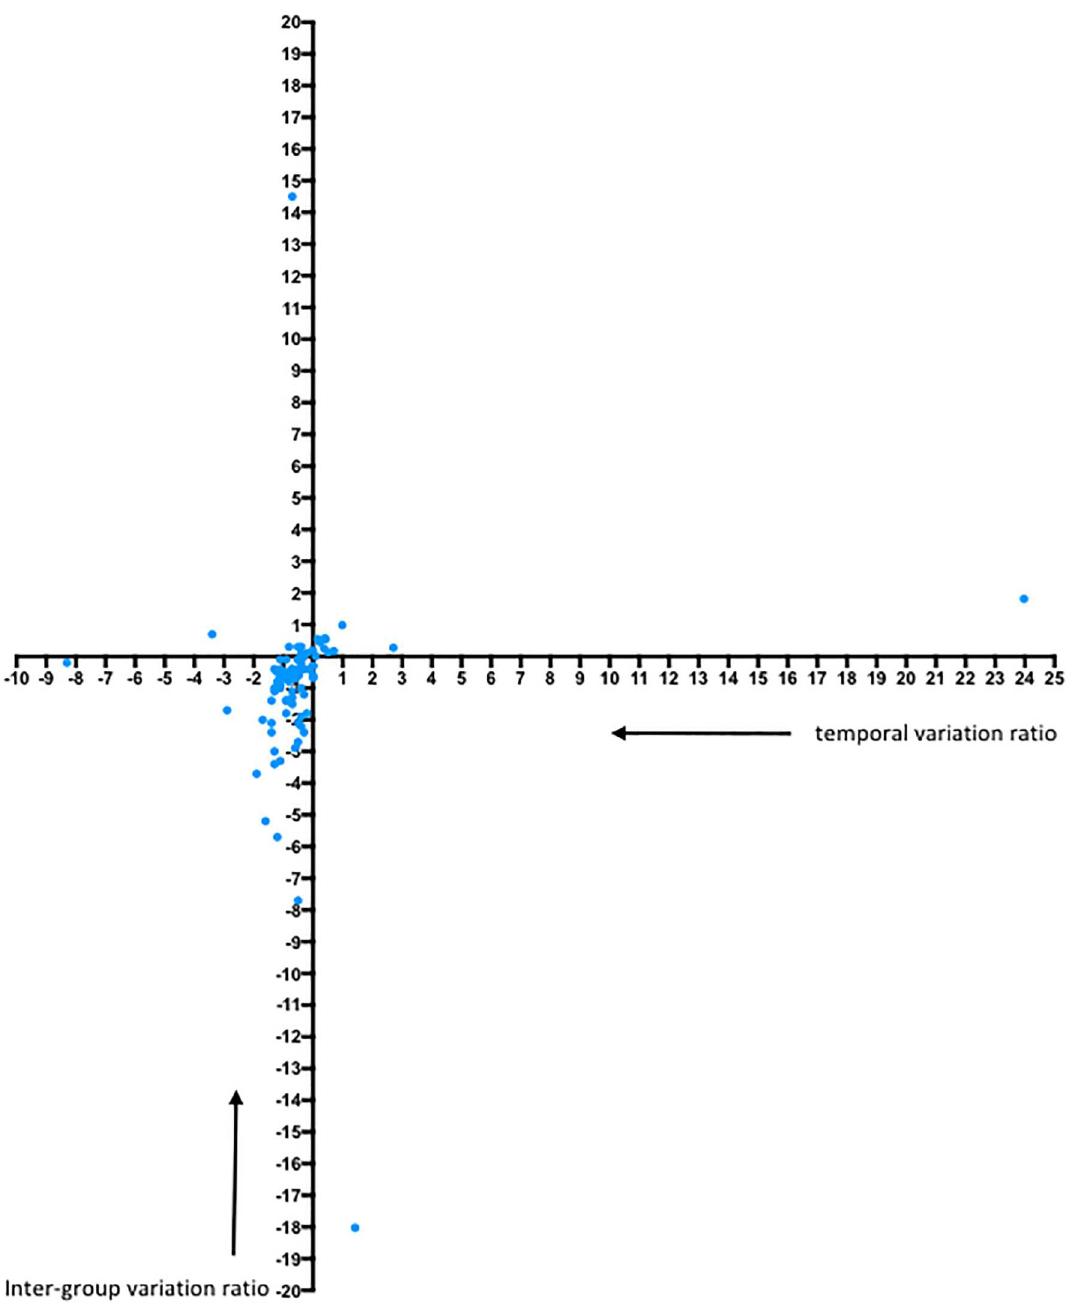
Fig 5. Dynamic shifts in gene expression occurring within each group with time was quantified as a ratio between temporal gene expressiondifferences observed in the treated group to that of the untreated group, for each of the 92 genes. This temporal variationratio was taken as the x-coordinate.Differences in gene expressionobservedbetweenthe two groups at each time point was quantifiedas a ratio betweendifferences observedbetweenthe two groups at viral setpoint to that observedat the late time point, for each of the 92 genes. This inter-groupvariation ratio was taken as the y- coordinate. This graphsshows the distribution of the 92 genesbased on the two calculatedratios. The polarizationtowards the doublenegative quadrantindicatesthat temporal variationoccurring with time within each group occurs in opposite directions; and that the inter-groupvariationobservedbetweenthe two groupsat the viral setpoint and the late time point are in oppositedirections. In addition,for 65 genestemporal variation ratio was < 1 indicating that the changesin gene expression accruedwith time in the untreated group was greater than changesaccrued with time in the treated group. Also, for 59 genes inter-group variationratio was < 1 indicatingthat differencesin gene expressionobservedbetweenthe two groupswere greater at the late time point comparedto those observedat the early time point. https://doi.org/10.1371/journal.pone.0173577.g005 PLOS ONE | https://doi.org/10.1371/journal.pone.0173577 March 15,